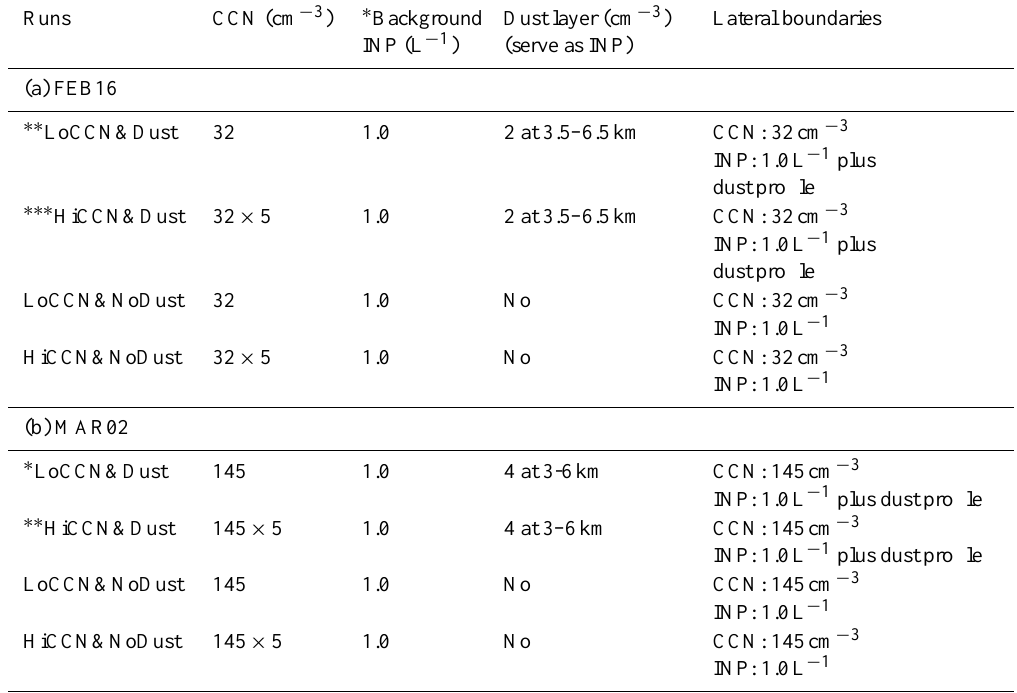
Table 1. The CCN and INP setup for the simulations of (a) FEB16 and (b) MAR02. Runs CCN (cm − 3 ) ∗ Background